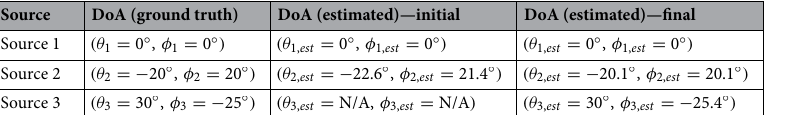
Table 1. Analysis of the DoA reconstruction fidelity. The original (ground truth) DoA values are compared to the estimated DoA values reconstructed using initial and final modes.